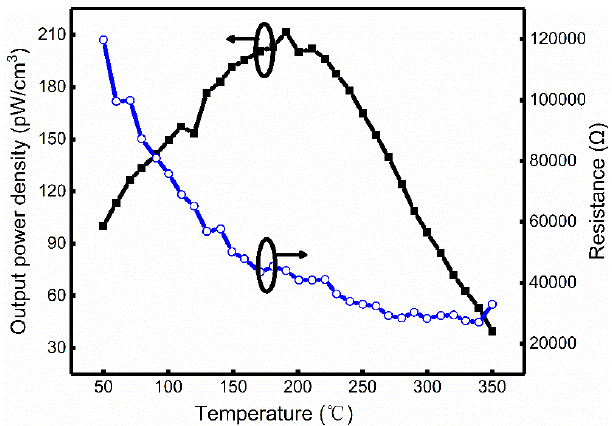
Figure 21. The temperature dependence of the output power density and the matched resistance measured in the unreduced NBBT8 ceramics. Reprinted with permission from [60]. Copyright 2018 Elsevier. T d is ∼ 140 °C for the NBBT8 ceramics.